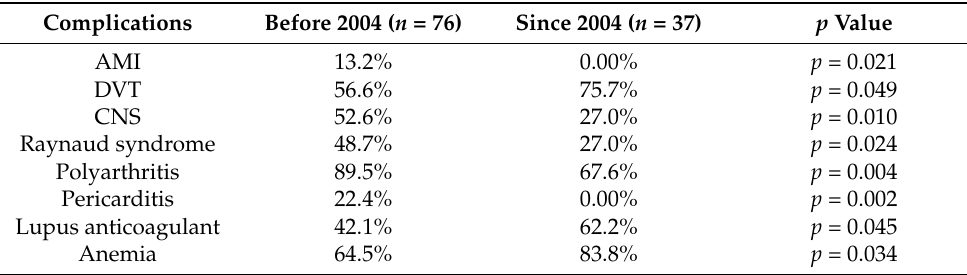
Table 4. Differences in the clinical symptoms and laboratory findings between patients of the APS group diagnosed with SLE before and since 2004.